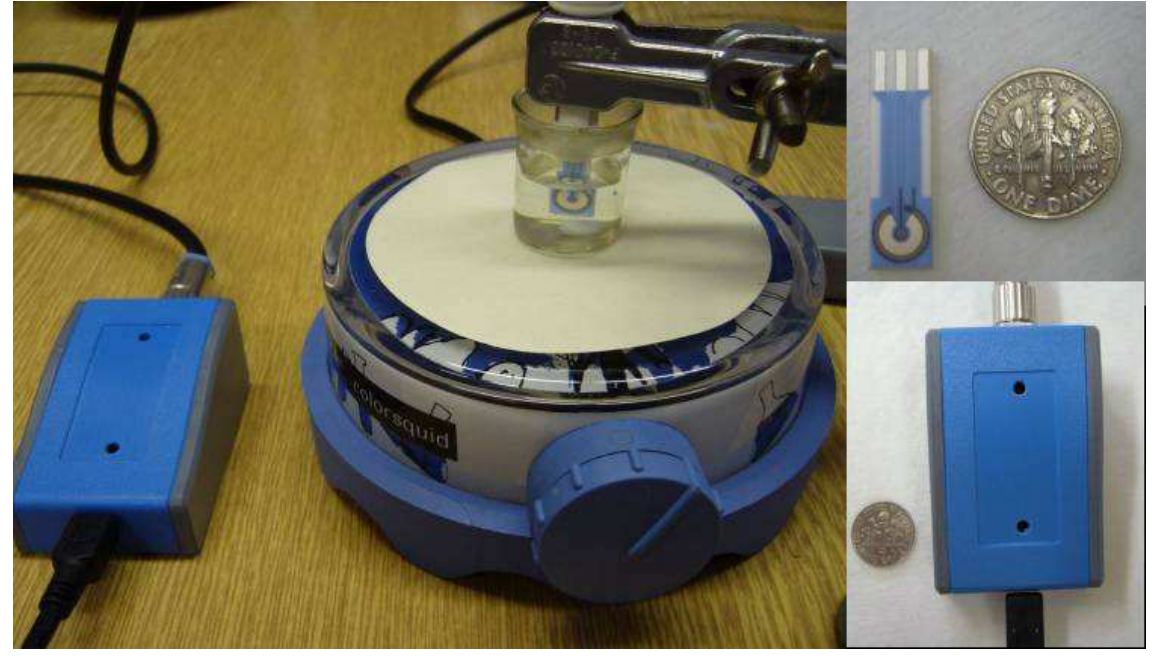
Figure 1. Photograph of the electrochemical device. Complete apparatus with EmStat detector, magnetic stirrer, reaction cell and sensor is presented in the left side. The reaction cell in the photograph was filled with water for better viewing. The screen-printed electrochemical sensor is presented in the right upper photograph. A blow-up of the EmStat detector is presented in the right bottom photograph. A U.S. dime coin (17.91 mm diameter) is shown for photographic scale